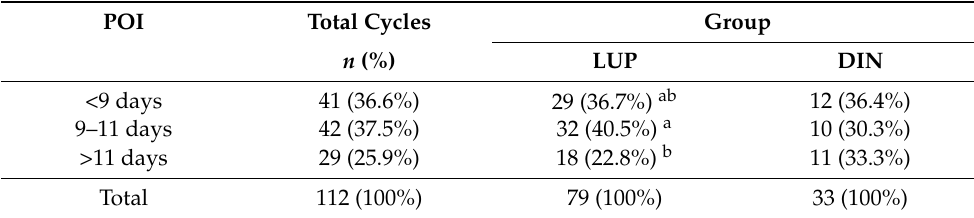
Table 3. Distribution of estrous cycles in jennies treated with luprostiol (LUP) or dinoprost tromethamine (DIN), depending on the prostaglandin–ovulation interval (POI; <9 days, 9–11 days, >11 days). POI Total